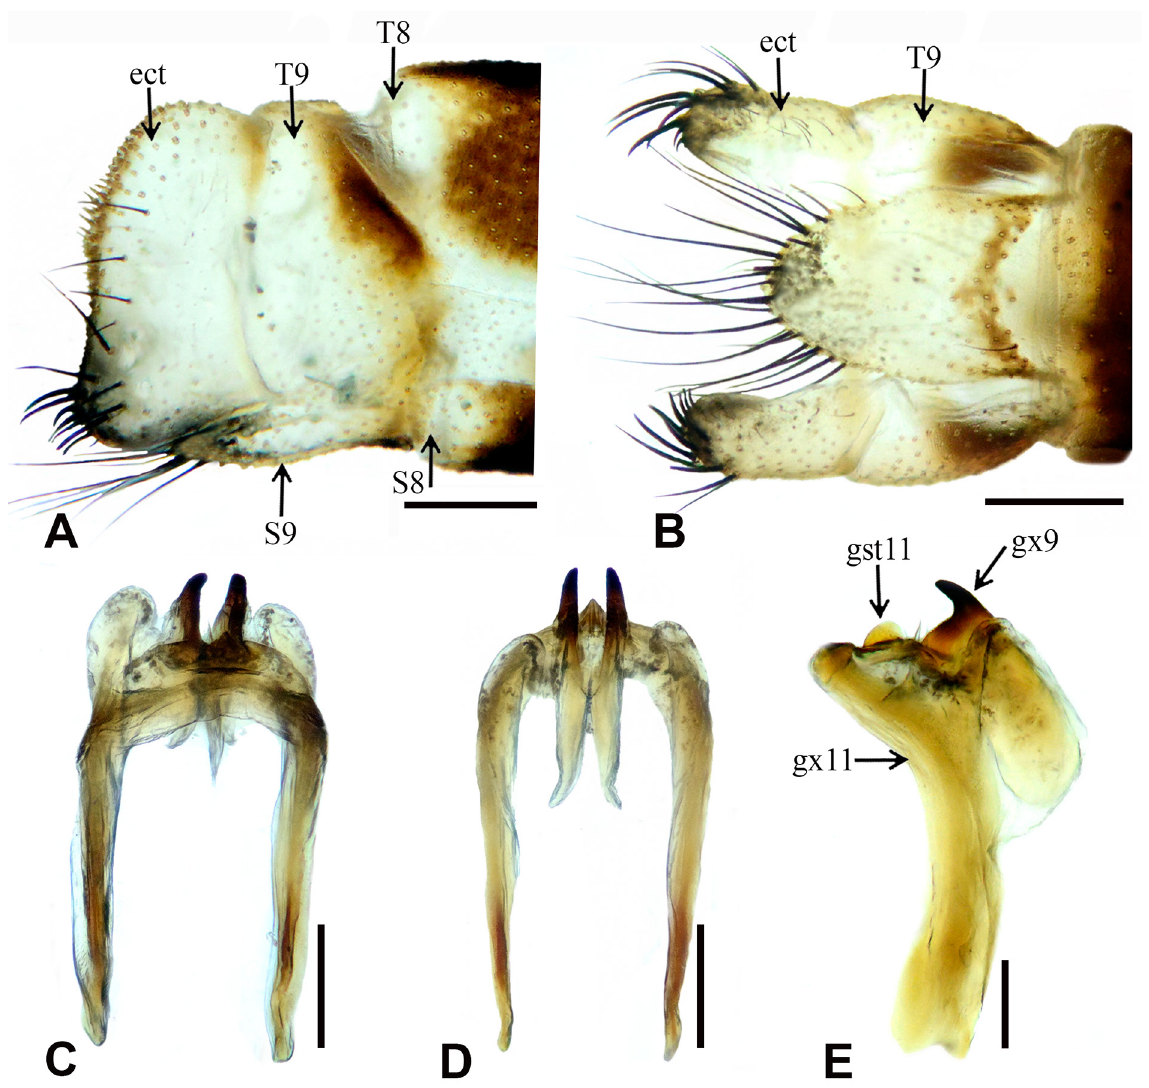
Fig. 15. Myrmeleon hyalinus hyalinus Olivier, 1811 (CAUPK000024). A . Male genitalia, lateral view. B . Same, ventral view. C . Complex of gonocoxites 9 + gonocoxites 11, dorsal view. D . Same, ventral view. E . Same, lateral view. Abbreviations: ect = ectoproct; gst11 = gonostylus 11; gx9 = gonocoxites 9; gx11 = gonocoxites 11; S = sternites; T = tergites. Scale bars = 0.5